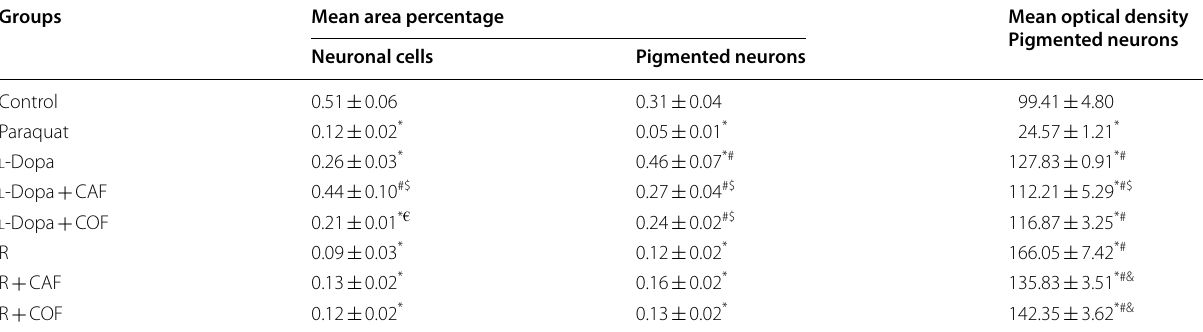
Table 1 Effect of each of l -dopa and rasagiline (R) alone or in combination with caffeine (CAF) or coffee (COF) on mean area percentage of neuronal cells and pigmented neurons as well as mean optical density of pigmented neurons in brain tissue sections in paraquat (PQ)-treated mice